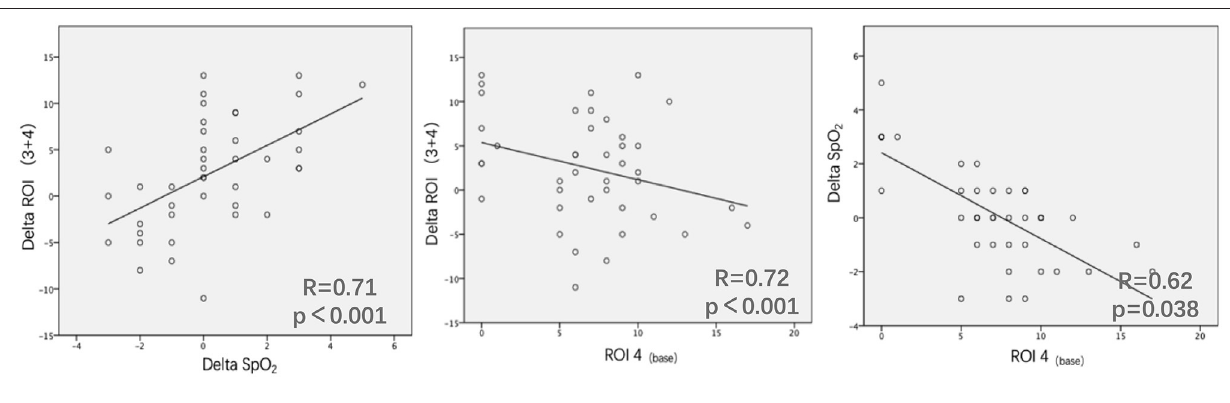
are shown in Figure 3 . The ROI 4 ( p = 0.0001) and COV (